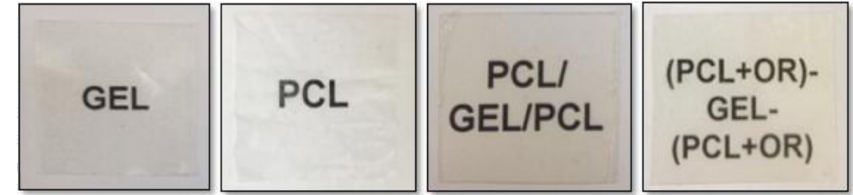
Figure 4. Contact transparency pictures, from left to right, GEL, PCL, PCL-GEL-PCL, and (PCL+OR)- GEL-(PCL+OR) films.